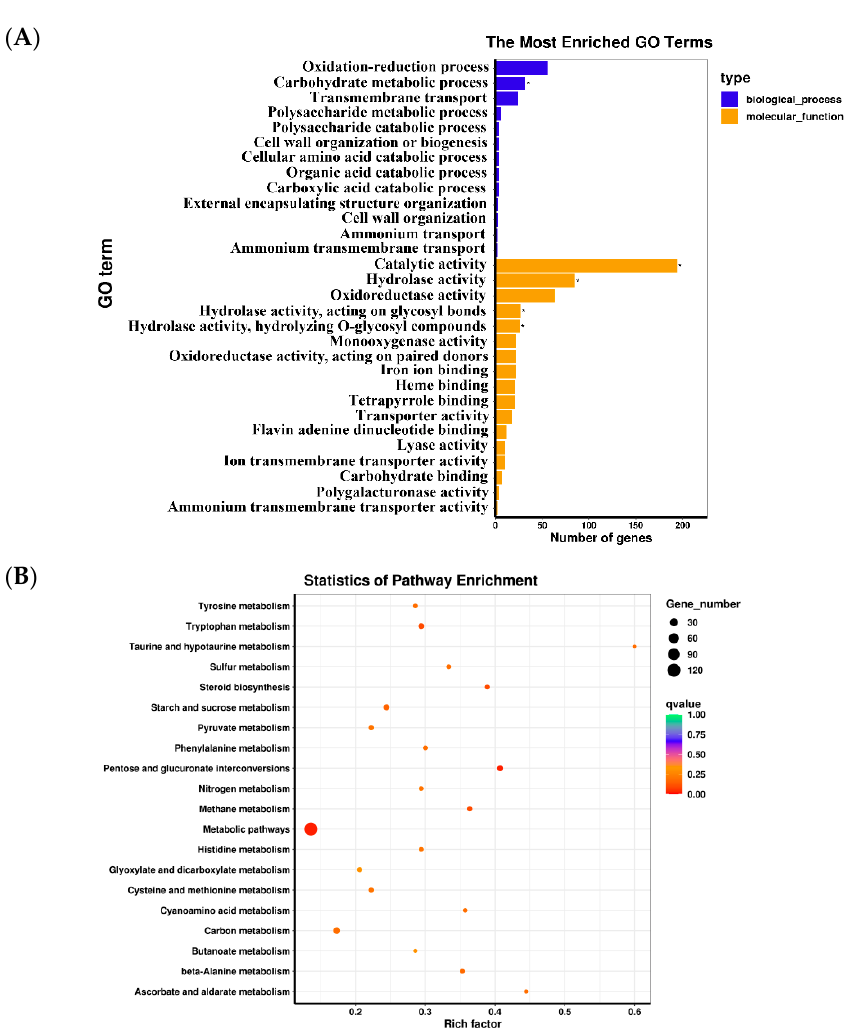
Figure 5. Enrichment analysis of DEGs. ( A ) GO enrichment of DEGs. ( B ) Bubble plot of KEGG enrichment of DEGs.